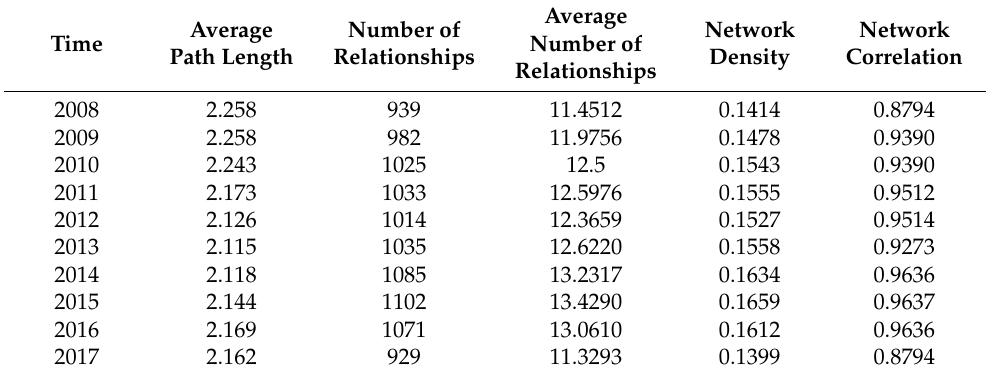
Table 3. The overall network structure features of the spatial correlation network of the UECC in the YRB.